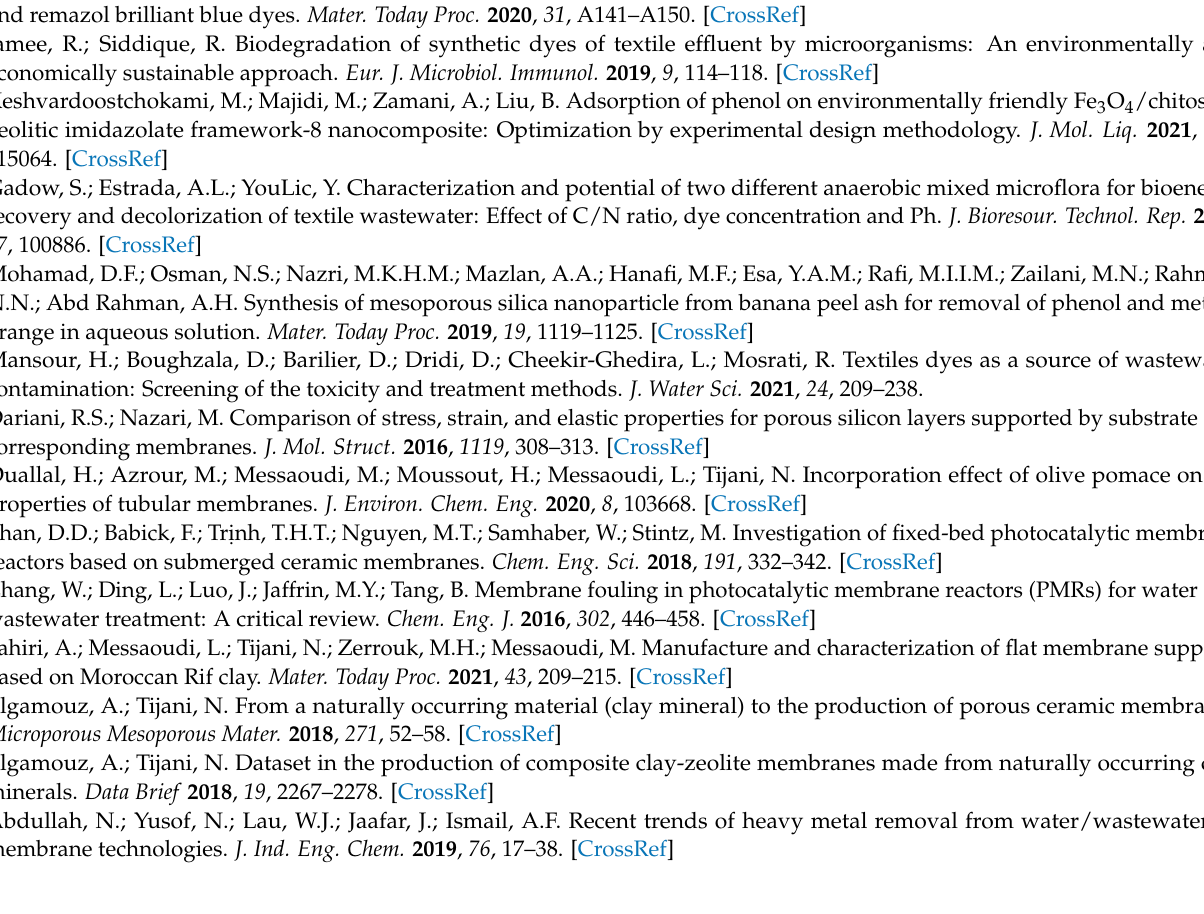
orange, Figure S4: The infrared spectra for the two membranes (a) FAM and (b) SOM membranes before and after filtration of methyl orange (MO), Figure S5: SEM micrographs and EDS analysis